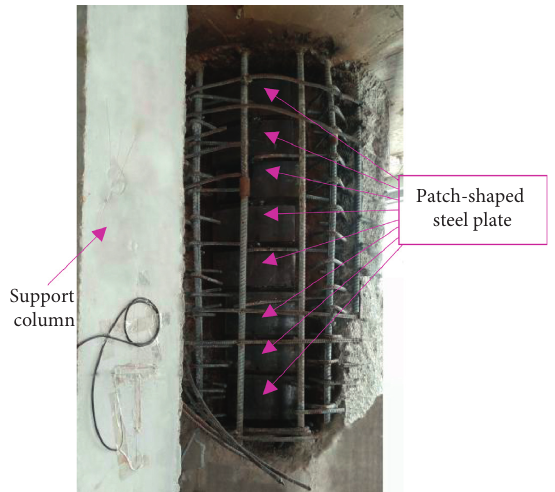
Figure 4: Crack repairing of the inner steel